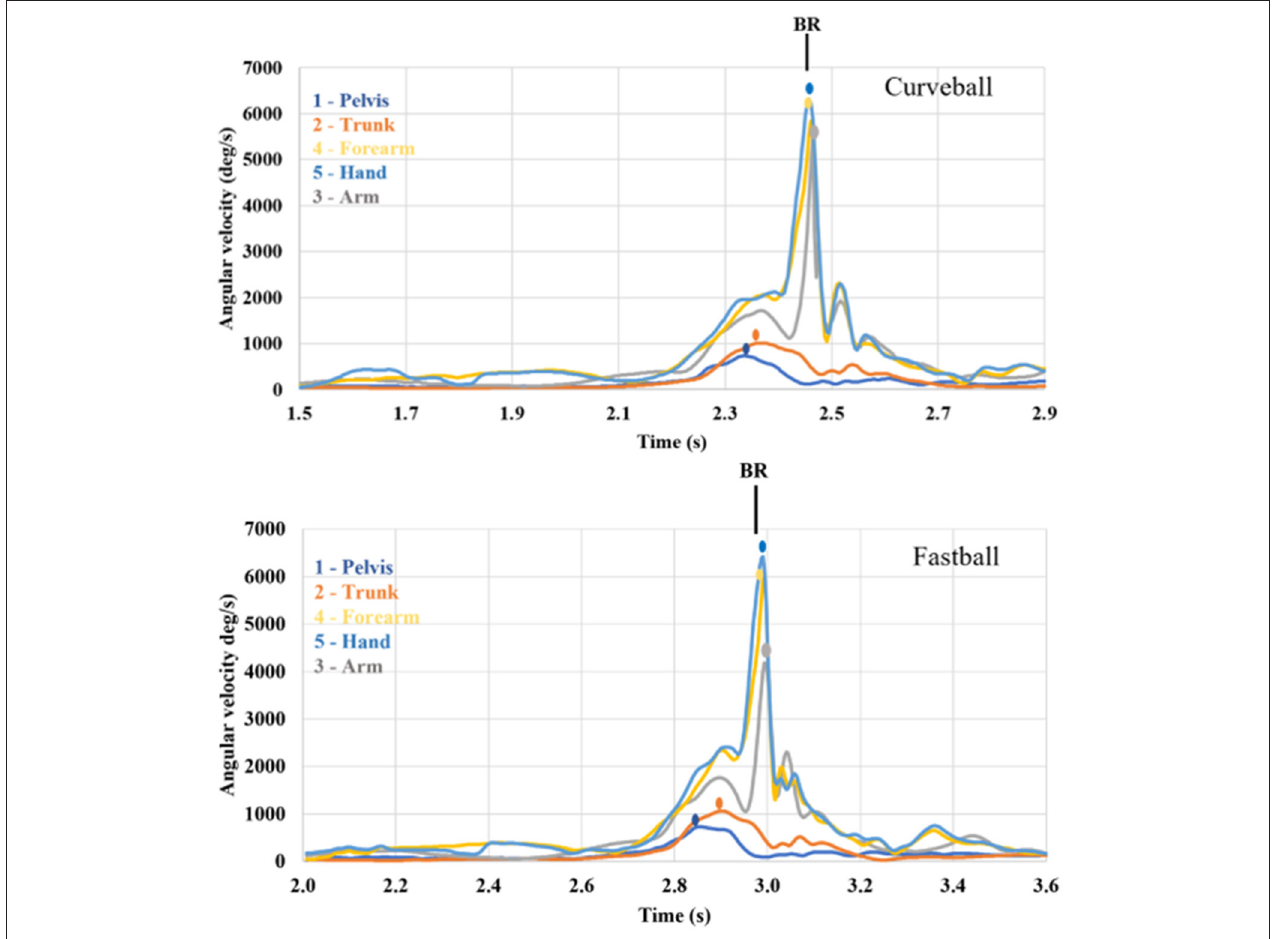
FIGURE 4 | Kinematic sequence data from a pitcher at the professional level. Data from a single curveball and fastball are plotted starting at balance point (time of maximum leg lift—greatest hip flexion). The kinematic sequence pelvis - > trunk - > forearm - > hand - > arm (KS: 12453) demonstrates a proximal upper extremity altered sequence (PUE) and was performed during both pitch types. The black vertical line identifies time of ball release (BR) for each pitch